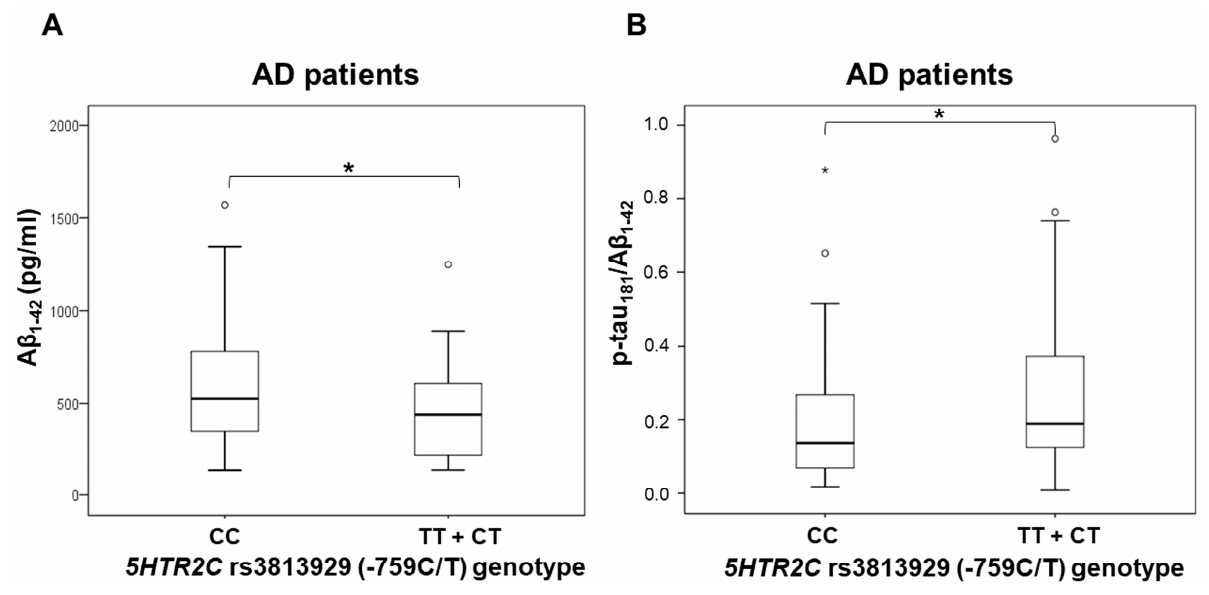
Figure 1. Levels of ( A ) A β 1–42 and ( B ) p-tau 181 /A β 1–42 ratio in AD patients with different 5HTR2C rs3813929 ( − 759C/T) genotypes. * p < 0.05.